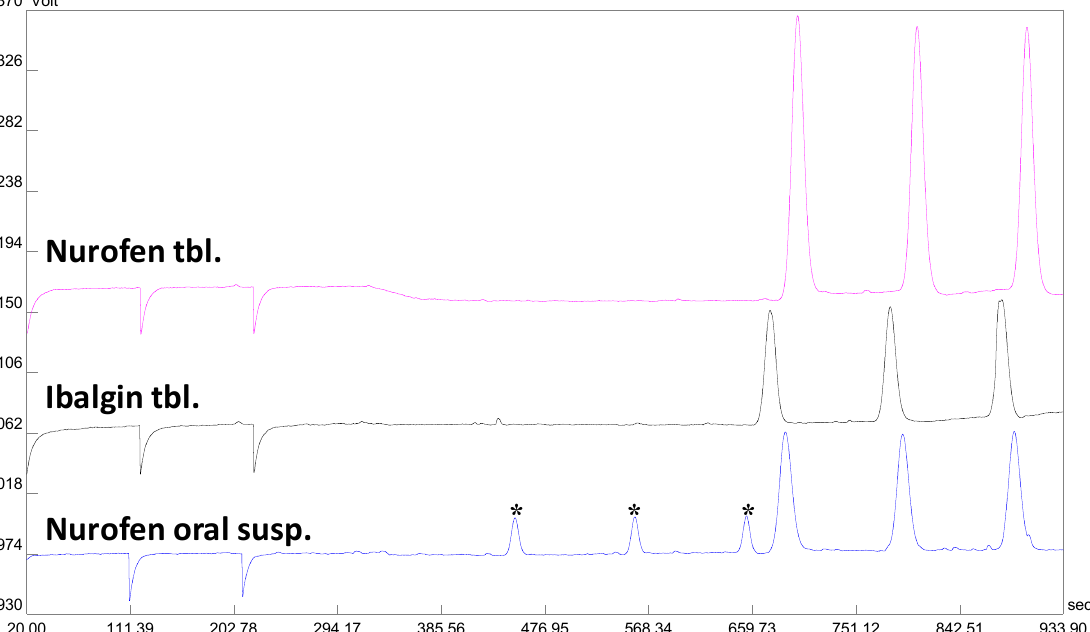
Table 4. Assay results for the determination of ibuprofen in its commercial drugs.